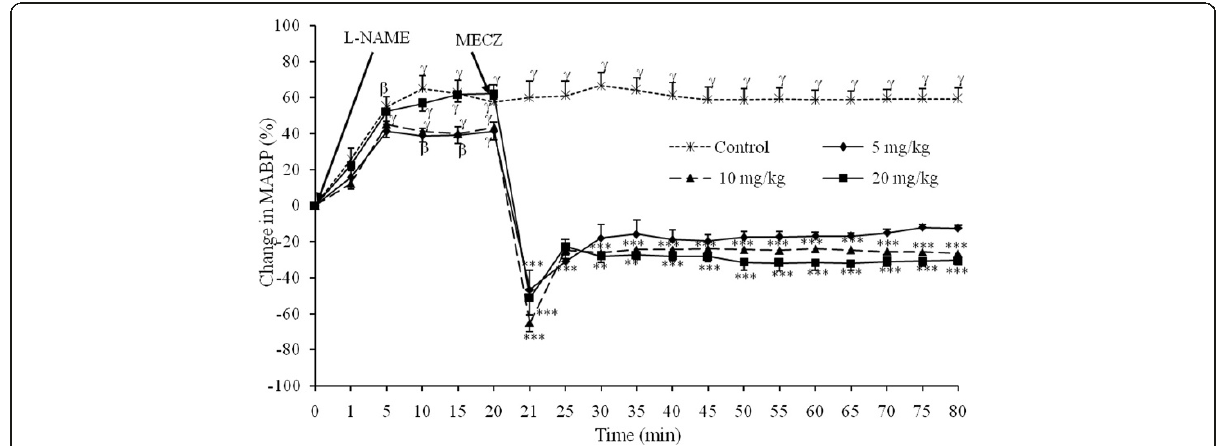
Figure 1 Effect of the methanol extract from Cinnamomum. zeylanicum stem bark on the mean arterial blood pressure in L-NAME- induced hypertensive rats. Each point represents the mean±SEM (n=5); α p<0.05, β p<0.01 and γ p<0.001 significantly different compared to the initial value (0 minute). **p<0.01 and ***p<0.001 significantly different compared to the value 20 minutes after L-NAME